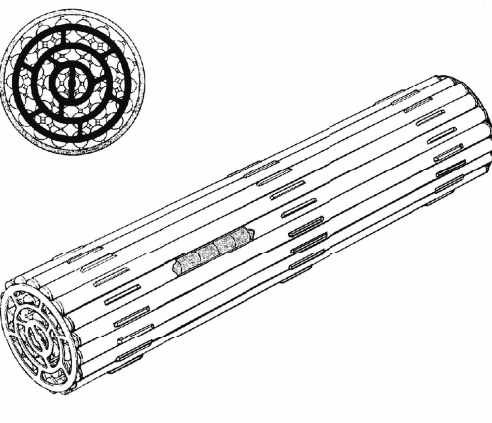
Figure 1: CANDU fuel element.